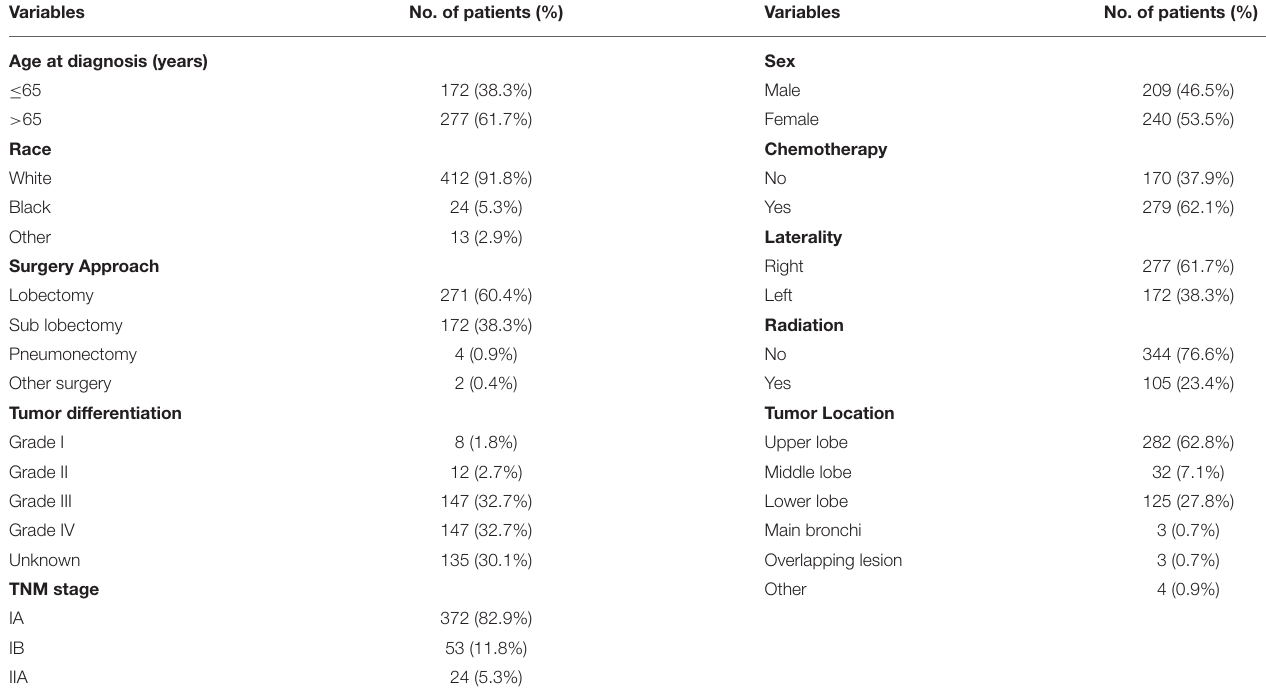
TABLE 4 | The characteristics in the SCLC patients with stage I-IIA who received surgery ( N = 449). Variables No. of patients